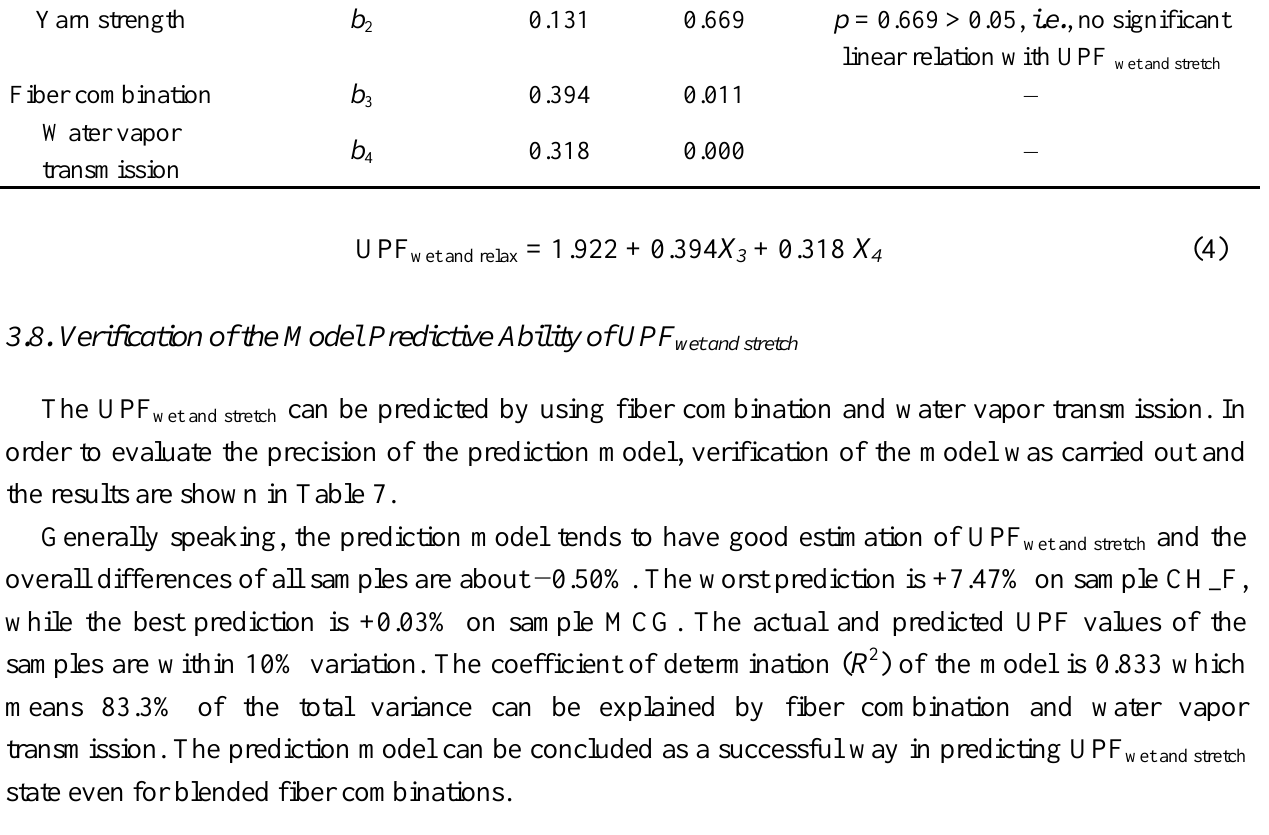
Table 7. Difference (%) between “Actual” and “Predicted” of UPF